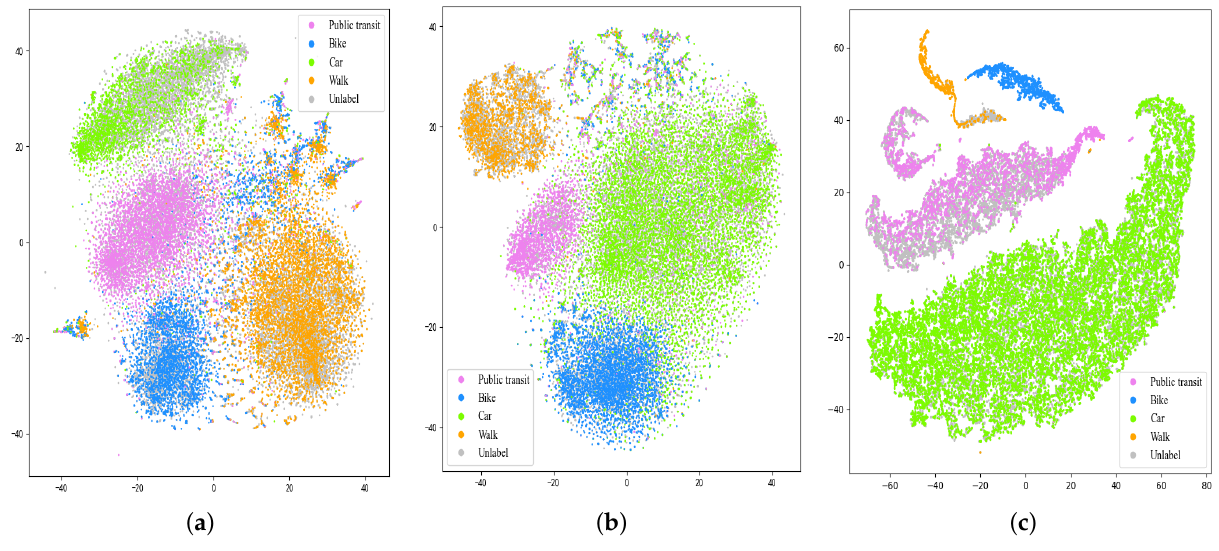
Figure 6. The visualization of the latent vectors. ( a ) Geolife dataset. ( b ) MTL Trajet 2017 dataset. ( c ) MTL Trajet 2016